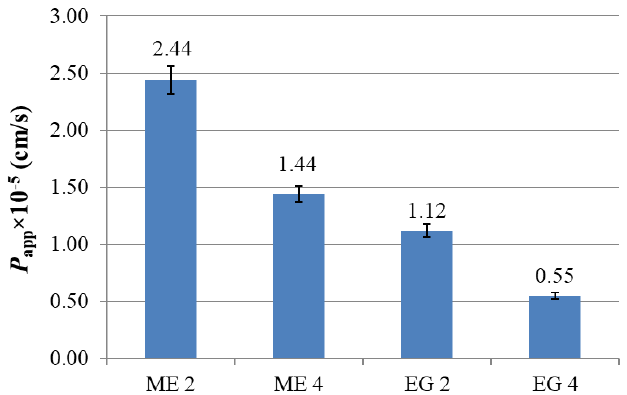
Figure 4. Apparent permeability constants of abietic acid loaded in microemulsions or emulgels.